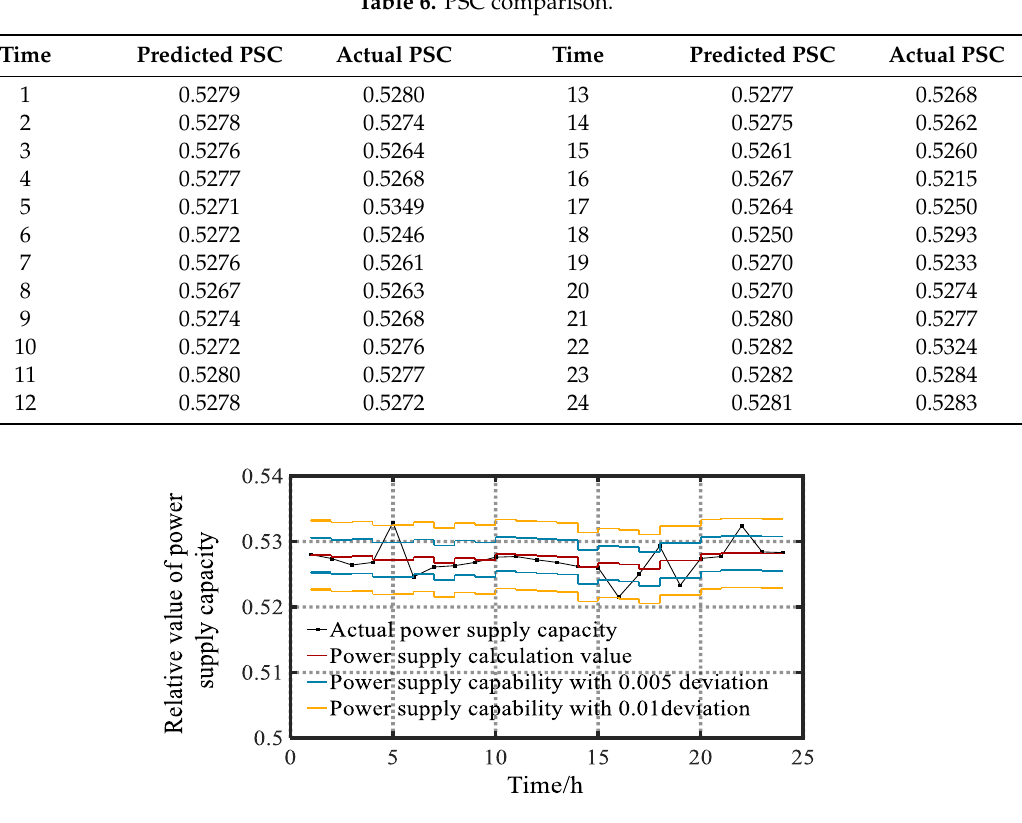
Figure 6. Power supply solution results.